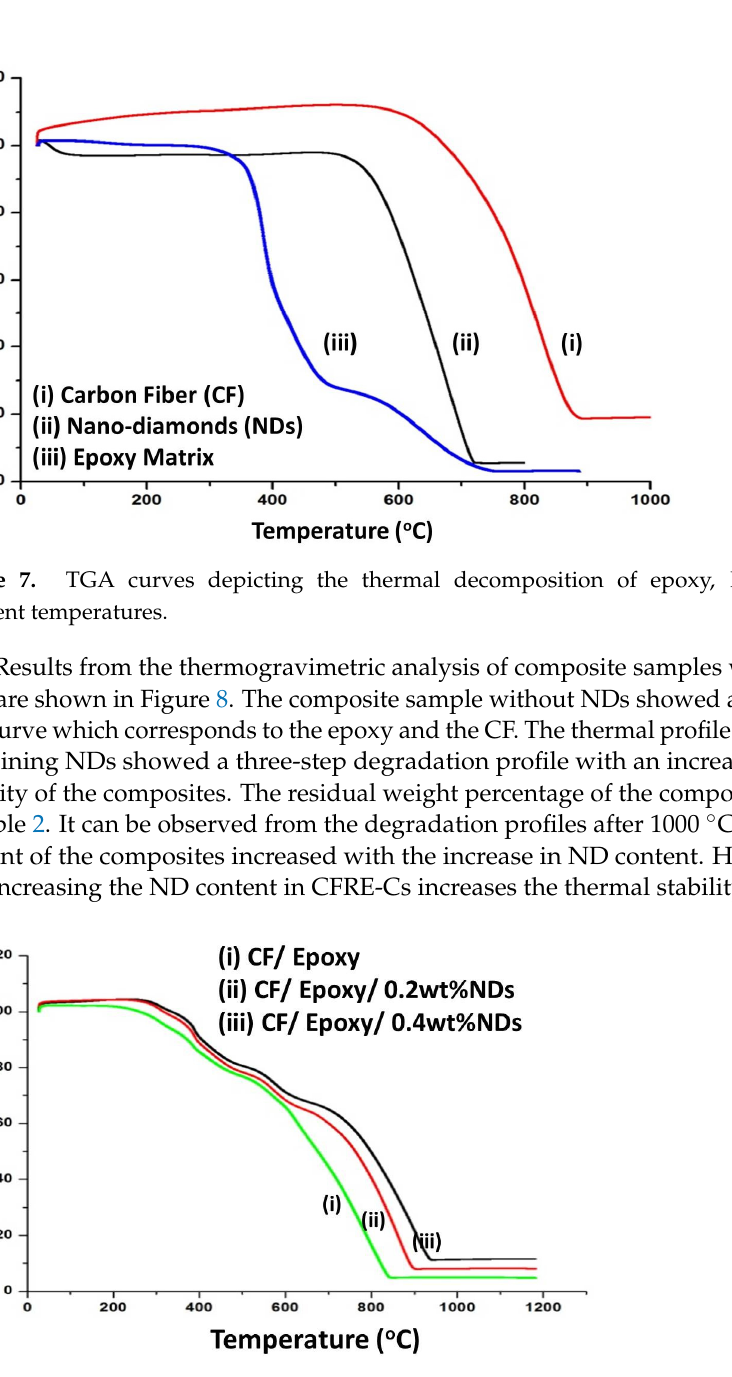
6 of 13 Figure 6. Thermal conductivity values of ( A ) CFRE-C, ( B ) CFRE-C containing 0.2 wt% NDs, and ( C ) CFRE-C containing 0.4 wt% NDs. Results from the thermogravimetric analysis of the components utilized to manufac- ture the CFRE-Cs, i.e., neat epoxy, NDs, and CFs, are shown in Figure 7. It can be observed that Araldite ® 5052 epoxy resin revealed a two-step weight-loss curve. After the initial weight loss due to hydration, the first step of weight loss took place at 380 °C followed by weight loss at 580 °C and leaving behind a residual char yield of 3.6%, which is the con- sequence of the creation of carbonaceous compounds due to chemical networking of the epoxy resin, whereas, the second step implicates the thermo-oxidative response conform-